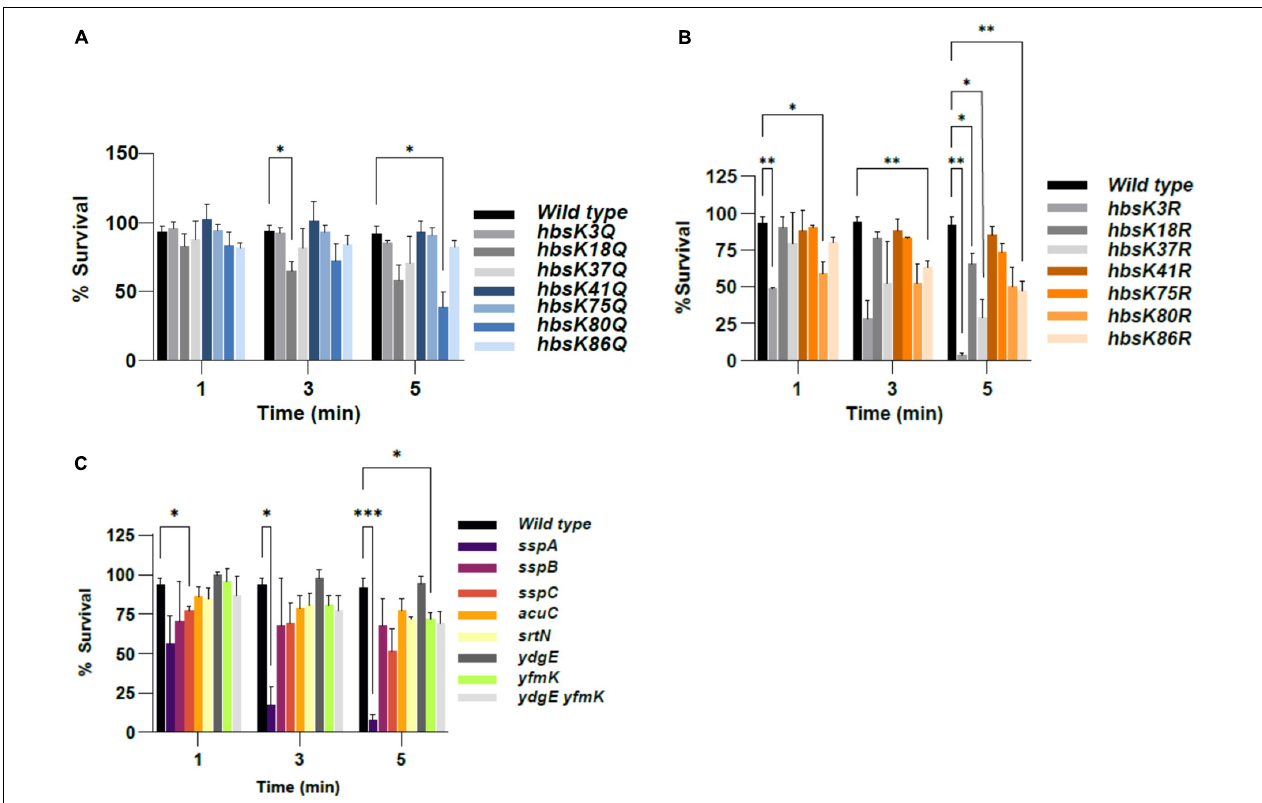
FIGURE 4 | The effects of acetylation on UV resistance. B. subtilis spores were isolated following growth in sporulation media for 48 h. Spore suspensions were exposed to UV light for 0, 1, 3, or 5 min. The percent survival at each time point was calculated as UV-resistant colony forming units (CFUs)/ml divided by total viable counts (CFU/ml), pre-treatment. Bar graphs represent the average percentages determined from at least three independent replicates with error bars representing standard deviations. All time points were normalized to the zero time point for each strain (not displayed), which was set at 100%. The strains used in panels (A–C) were as described in the legend for Figure 1 . Statistical analyses were performed using GraphPad Prism 9. Two-factor ANOVAs with repeated measures, and a post hoc Dunnett square analysis were used to determine statistical significance. A p -value of ≤ 0.05 was considered significant. ∗ p < 0.05, ∗∗ p < 0.01, ∗∗∗ p <